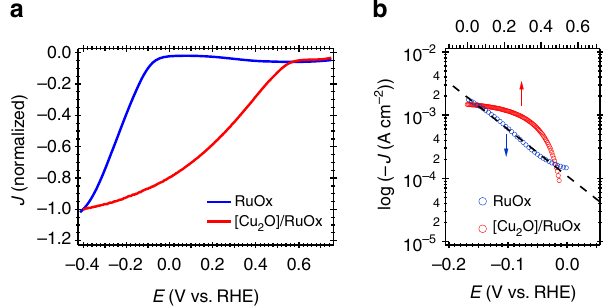
Figure 2 | J-E behaviour of the dark electrocatalyst and the illuminated photocathode. ( a ) J-E characteristics normalized for clarity at an applied potential where HER occurs in both systems and ( b ) J-E characteristics represented as log [ (cid:2) J or (cid:2) J ph ] versus E . The samples were measured in a pH ¼ 5 phosphate-sulfate